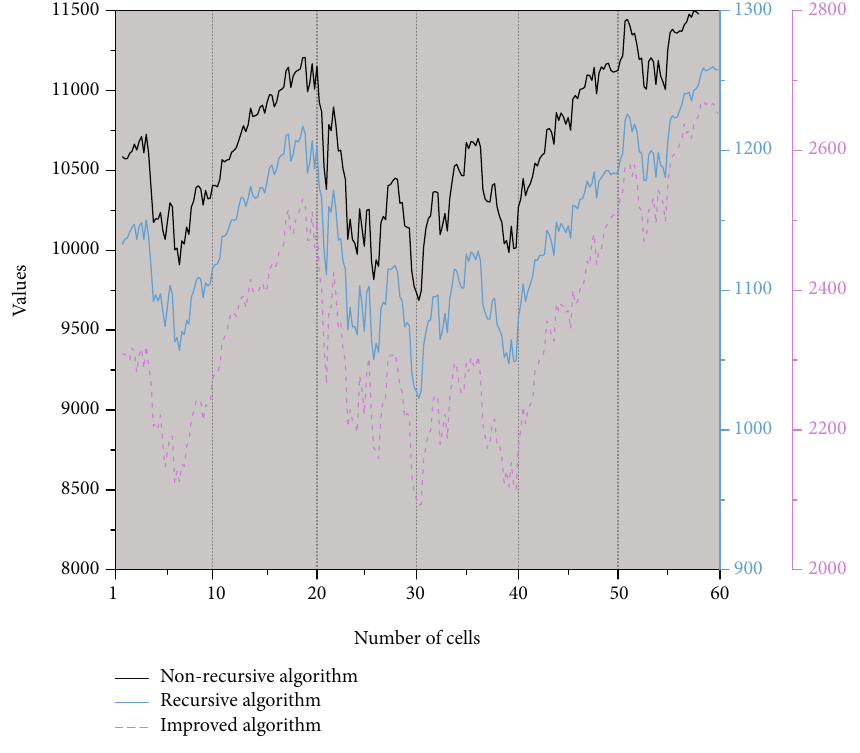
Figure 3: Comparison chart of statement fl uency.